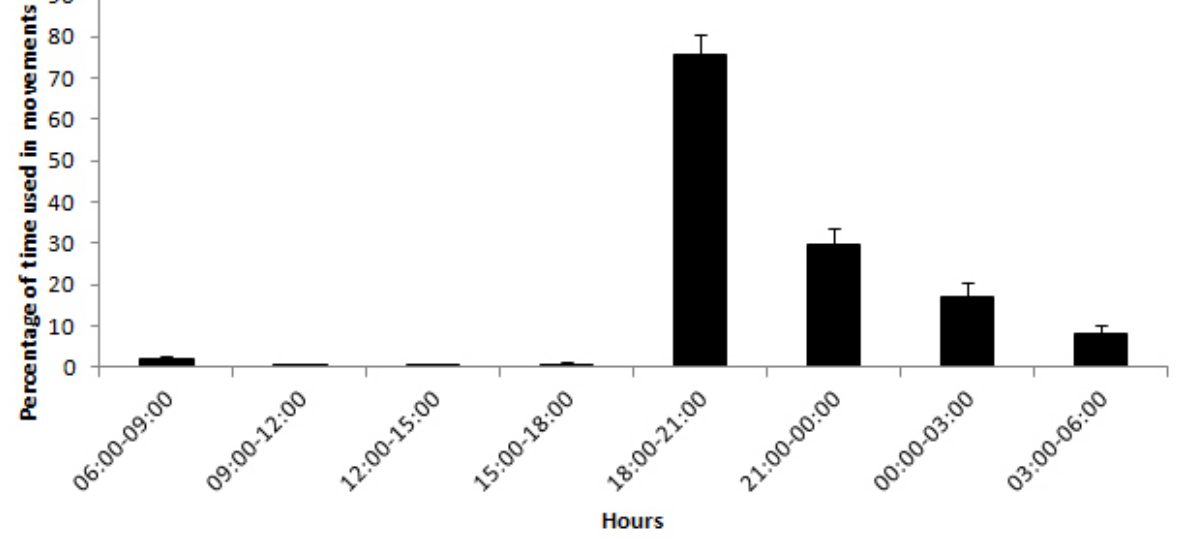
Figure 2. Differences in activity pattern during photophase and scotophase. Note that the peak of activity occur during the first quarter of the